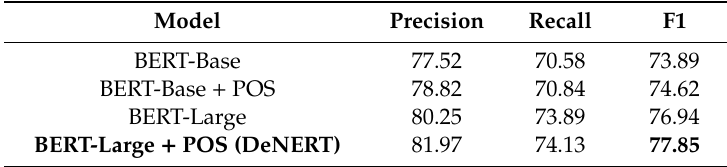
Table 4. Experiment result on EWNERTC dataset.